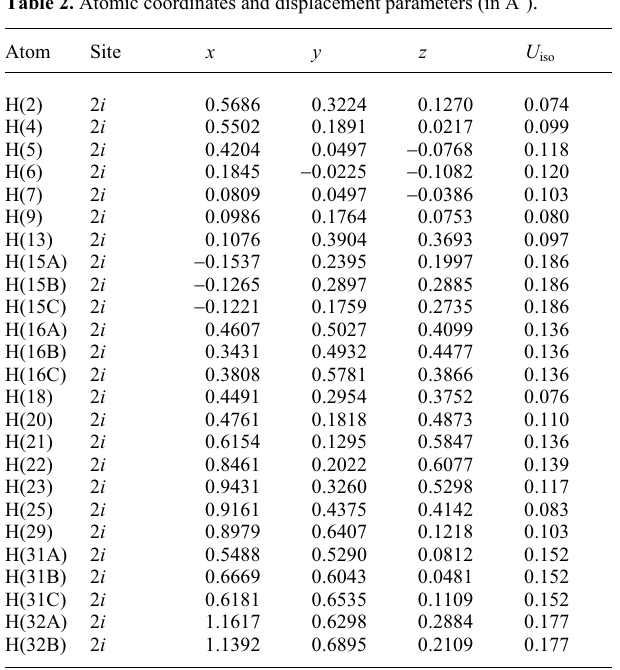
Table 2. Atomic coordinates and displacement parameters (in Å 2 )